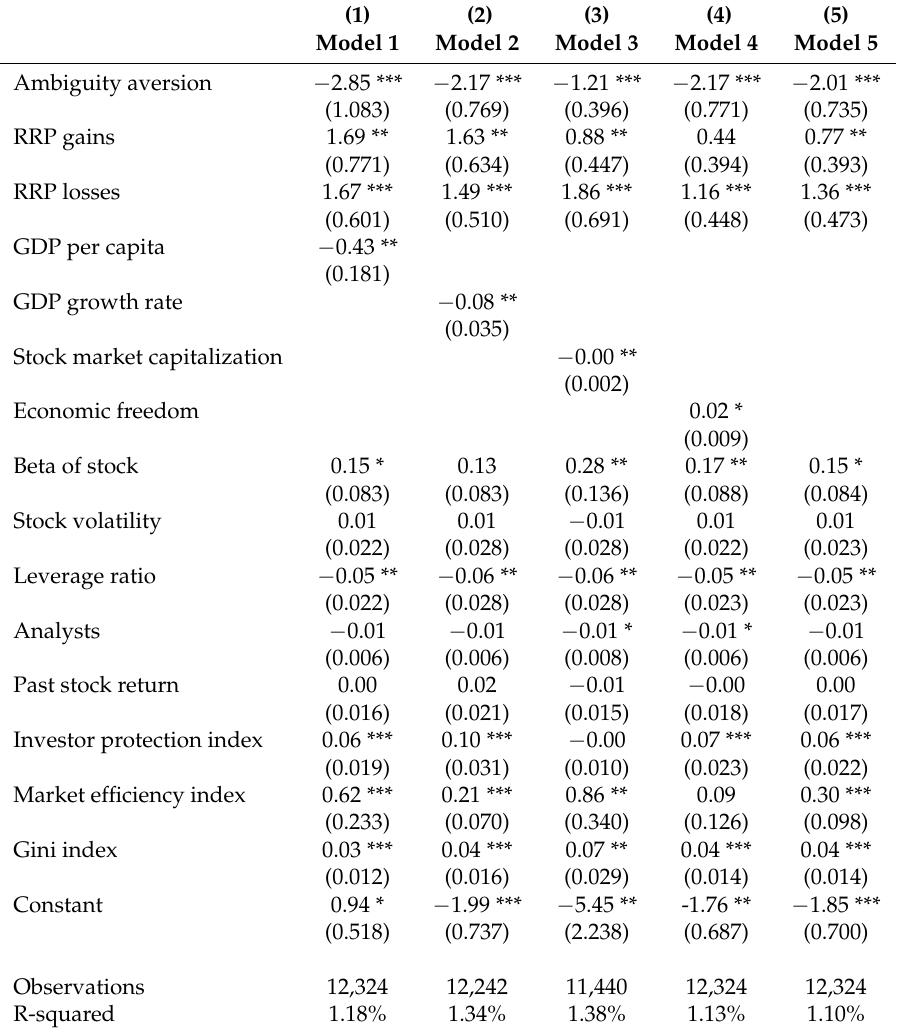
Table 9. Regressions with different controls for the equity premia, ambiguity aversion and risk